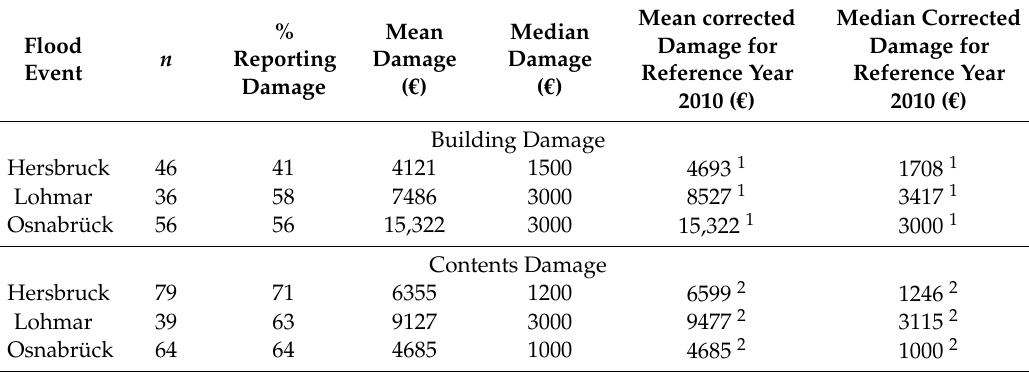
Table 5. Damage to building and contents in the three study